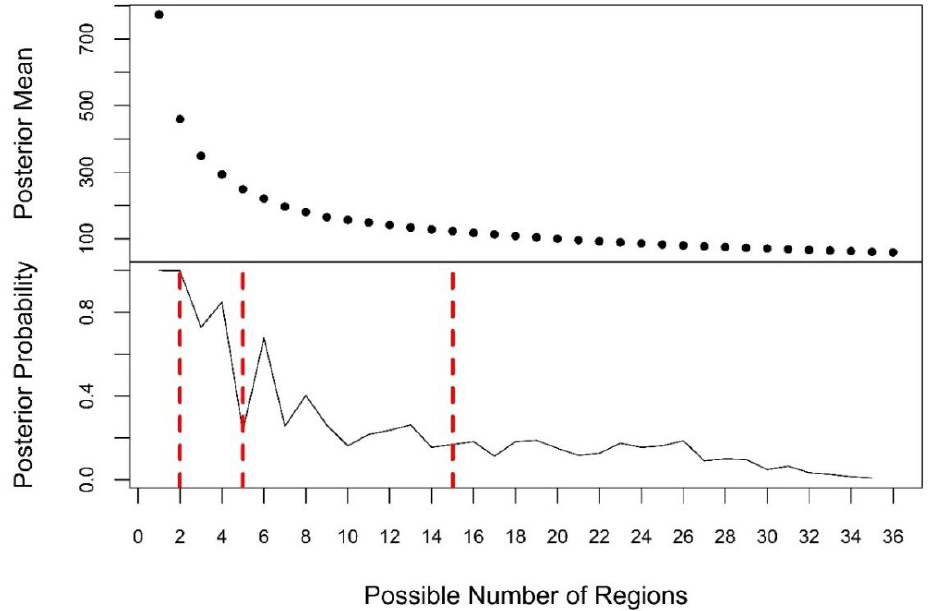
ISPRS Int. J. Geo-Inf. 2019 , 8 , 458 Figure 10. Bayesian change-point (BCP) results of within-zone heterogeneities (posterior mean). The red line shows the partitioning of the sequence by BCP, according to the within-zone heterogeneity.